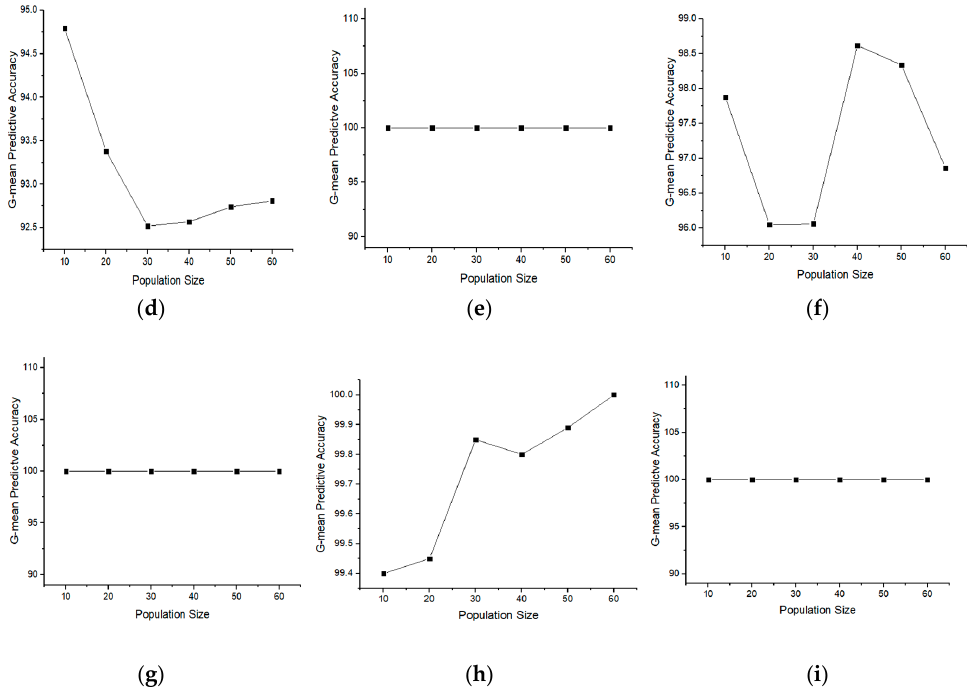
Figure 2. ( a )–( i ) The G-mean accuracy results of rCBR-BGOA with different population sizes for Breast, CAR, CNS, Colon, DLBCL, GLIOMA, Lung, Leukemia, and SRBCT datasets. ( a ) Breast dataset. ( b ) CAR dataset. ( c ) CNS dataset. ( d ) Colon dataset. ( e ) DLBCL dataset. ( f ) GLIOMA dataset. ( g ) Lung dataset. ( h ) Leukemia dataset. ( i ) SRBCT dataset.